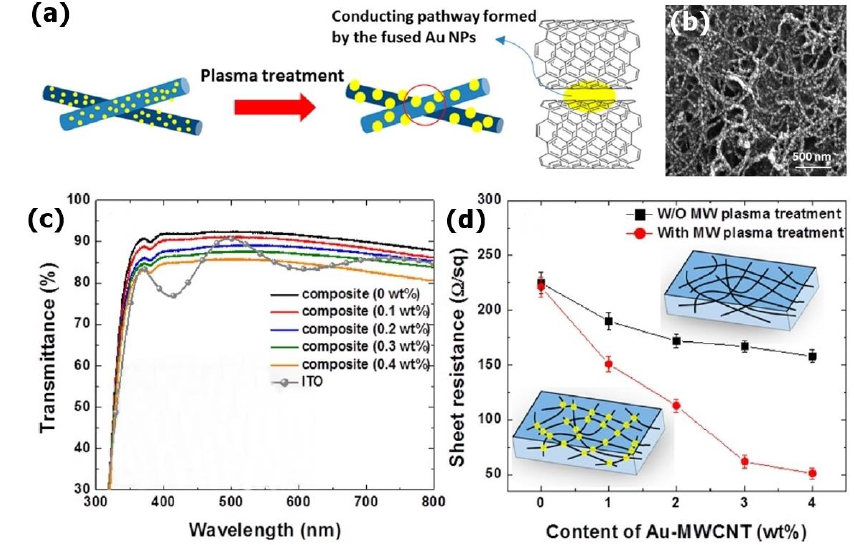
Figure 13. ( a ) Multi-wall carbon nanotubes are uniformly covered with anchored Au nanoparticles. Through a plasma treatment, these nanoparticles fuse the nanotubes and create conductive junctions. ( b ) SEM of a gold nanoparticle-covered MWCNT network. ( c ) The transmission of the composite embedded in a PEDOT:PSS matrix exhibits optical transmittance values of the order 85–90% depending on composition. ( d ) The sheet resistance is largely decreased through the plasma treatment of the Au nanoparticles anchored on the MWCNTs. (Reproduced by permission from ref. [157]) .